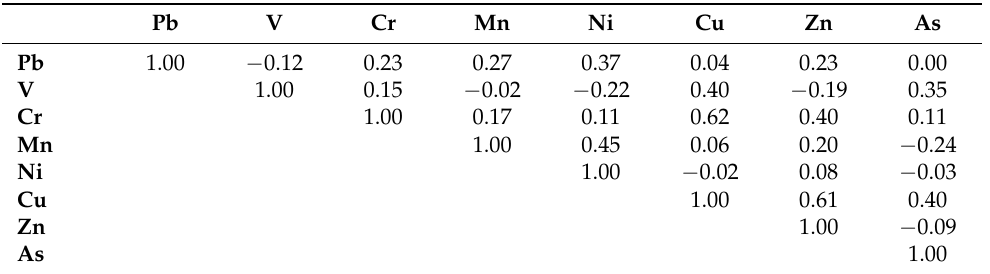
Table 4. Pearson’s correlation matrix among metals in FA (N = 13; p < 0.05). Correlation coeffi- cients > 0.69 are indicated in